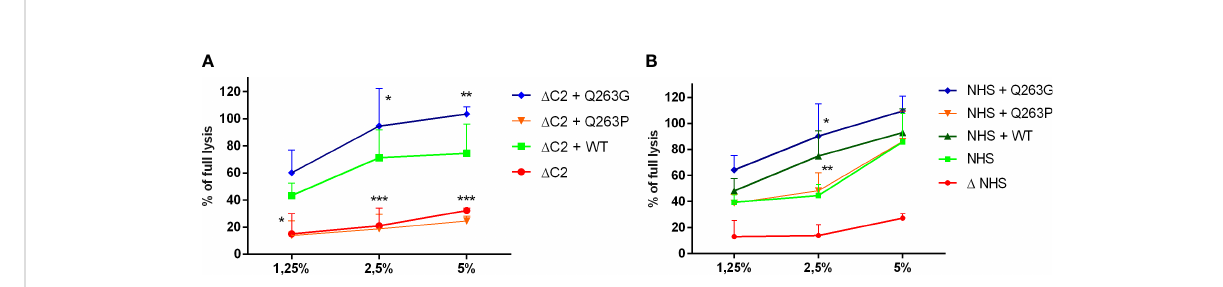
FIGURE 1 CDC of serum supplemented with C2 variants on Ramos cell. Ramos cells were loaded with calcein-AM, sensitized with rituximab and incubated with (A) C2-depleted serum ( D C2) or (B) normal human serum (NHS) supplemented with puri fi ed, recombinant C2 variants. The fl uorescence readout of released calcein was calculated as percentage of full lysis of cells achieved by incubation with 30% DMSO. Symbols *, **, and *** denote statistical signi fi cance at p levels <0.05, <0.01, and <0.001, respectively, according to Holm-Sidak ’ s multiple comparison